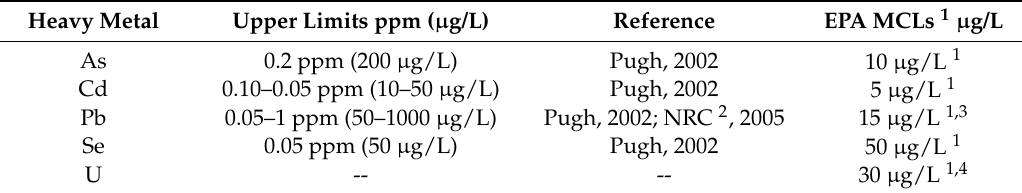
Table 1. Recommended standards for upper limits of potentially toxic water contaminants for sheep and maximum contaminant levels for humans.